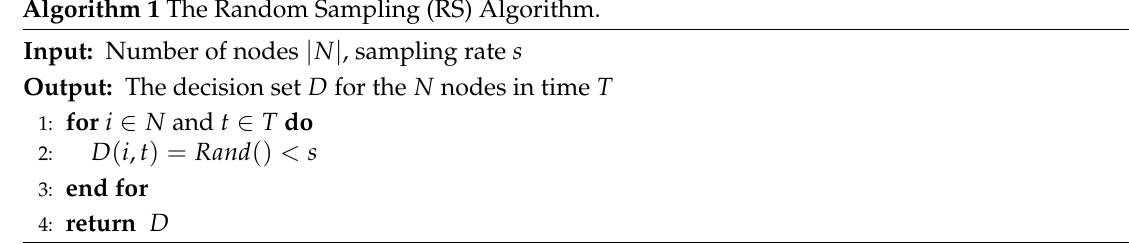
Algorithm 1 The Random Sampling (RS)